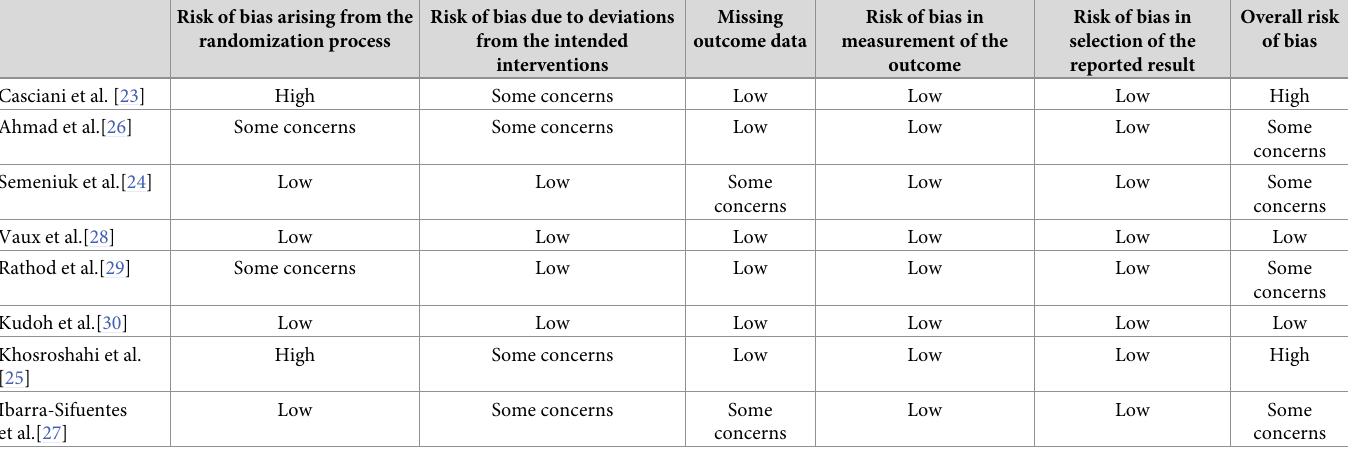
Table 2. Risk of bias according to revised Cochrane risk-of-bias tool for randomized trials. Risk of bias arising from the randomization